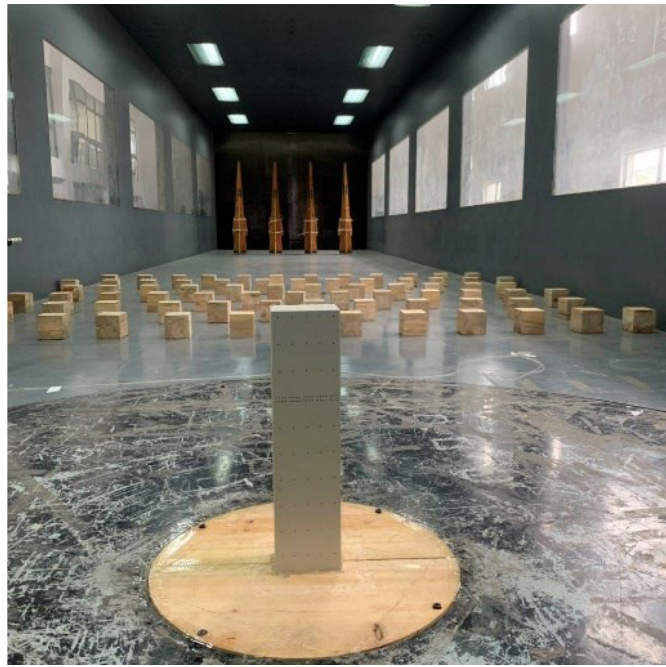
Figure 2. Experimental model.